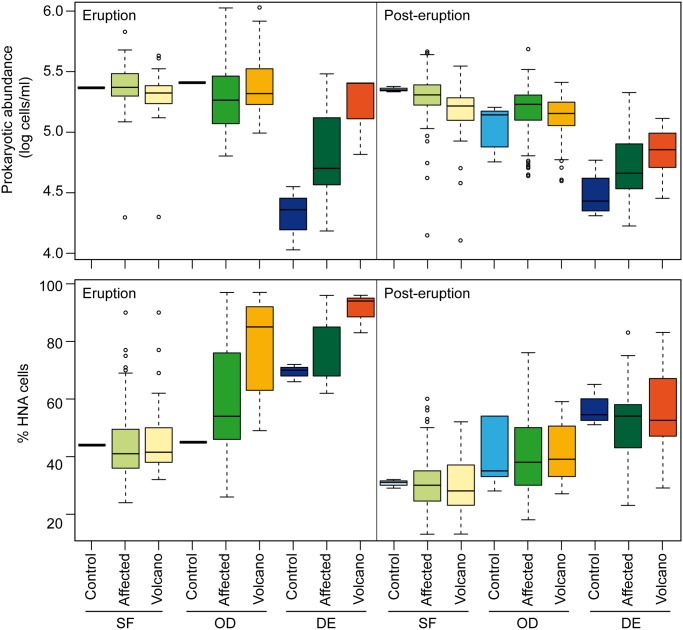
Distribution of prokaryotic abundace (cells ml-1 in log units) and the percentage of high-nucleic acid content cells (% HNA) in samples collected during the eruptive phase (left pannels) and the post-eruptive phase (right pannels).The samples are grouped in different categories by depth (SF: subsurface, 0–70 m; OD: oxygen depleted waters, 70–200 m; DE: deep waters, 200–1900) and location (Control: stations in the control zone, Affected: stations in all affected areas, Volcano: affected stations in the vicinity of the volcano; see S1 Table).